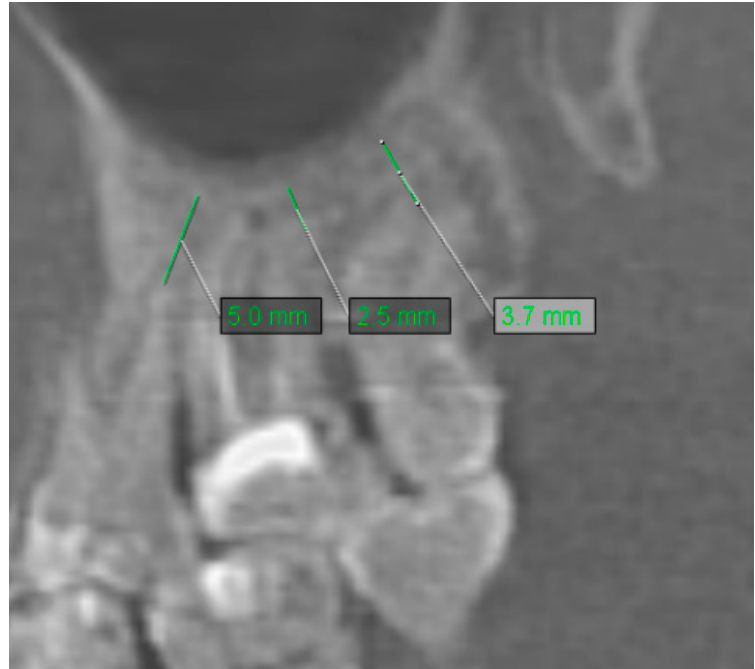
Figure 8. Sample measurement of distance of the teeth to maxillary sinus .